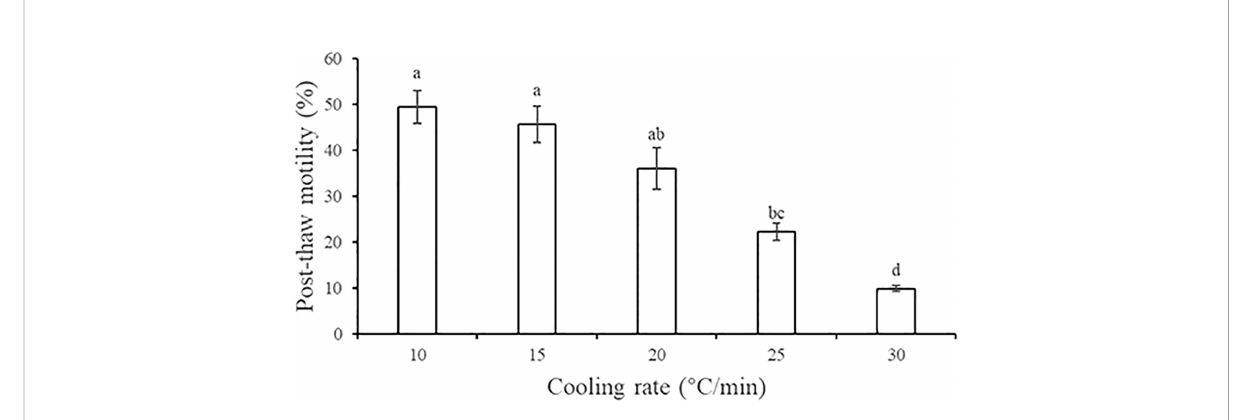
FIGURE 2 Effect of fi ve cooling rates on the post-thaw motility of A. japonicus spermatozoa. Data are presented as the means ± SE (n = 4). Different letters indicate signi fi cant differences (P < 0.05). Data were not transformed when performing one-way ANOVA.